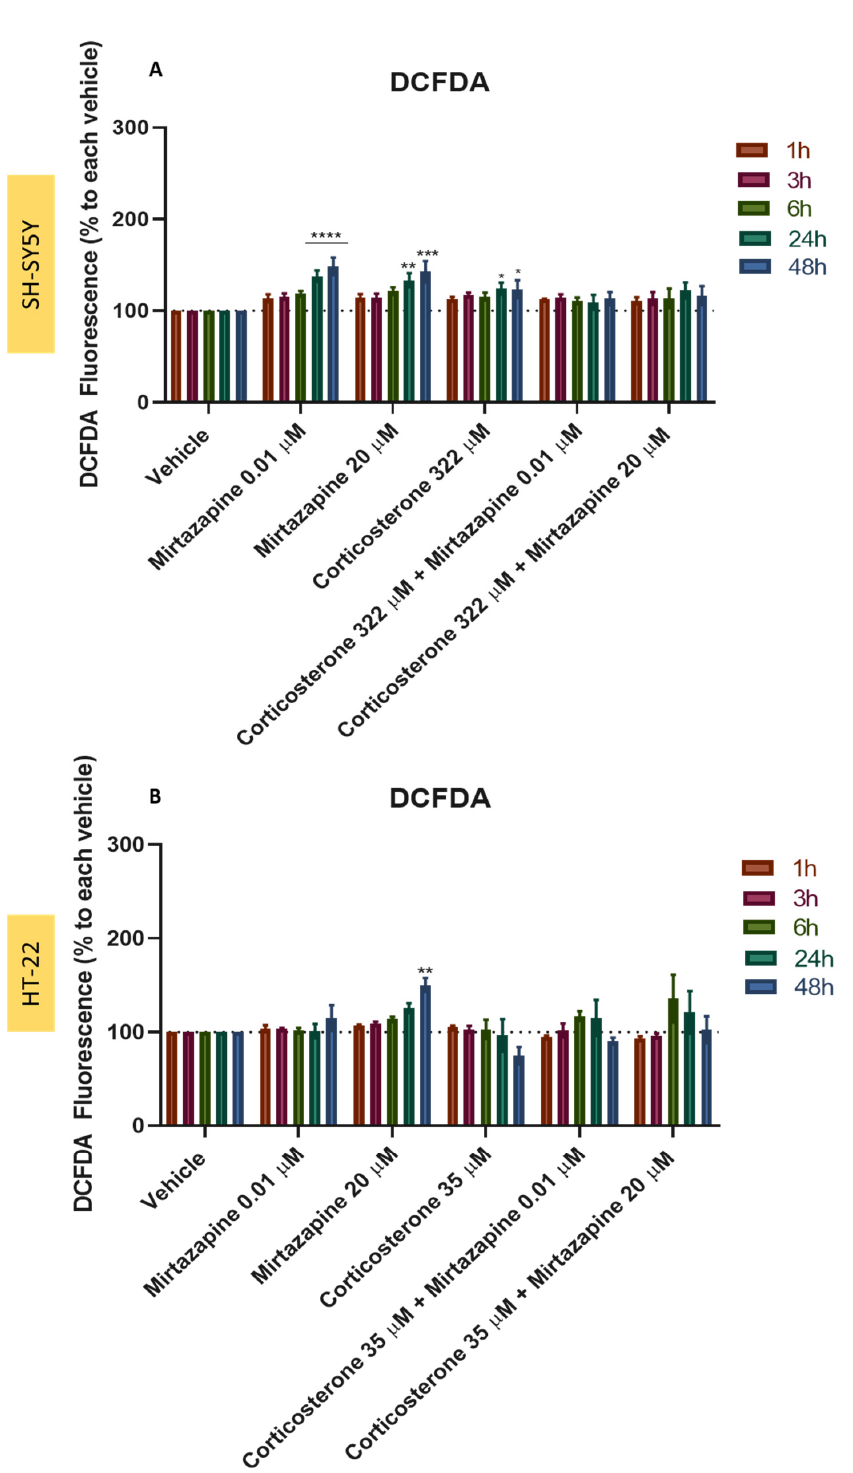
Figure 18. Effect on ROS production of 1 h, 3 h, 6 h, 24 h, and 48 h-incubation of ( A ) 322 µ M of corticosterone, 0.01 µ M/20 µ M of mirtazapine and 322 µ M of corticosterone + 0.01 µ M/20 µ M of mirtazapine (SH-SY5Y cells) and ( B ) 35 µ M of corticosterone, 0.01 µ M/20 µ M of mirtazapine and 35 µ M of corticosterone + 0.01 µ M/20 µ M of mirtazapine (HT-22 cells), determined by DCFDA assay. The results represent the mean ± SEM of 2–6 independent experiments, expressed as the percentage of each vehicle (100%) for each period. Statistically significant * p < 0.05, ** p < 0.01, *** p < 0.001, and **** p < 0.0001 vs. vehicle, for each